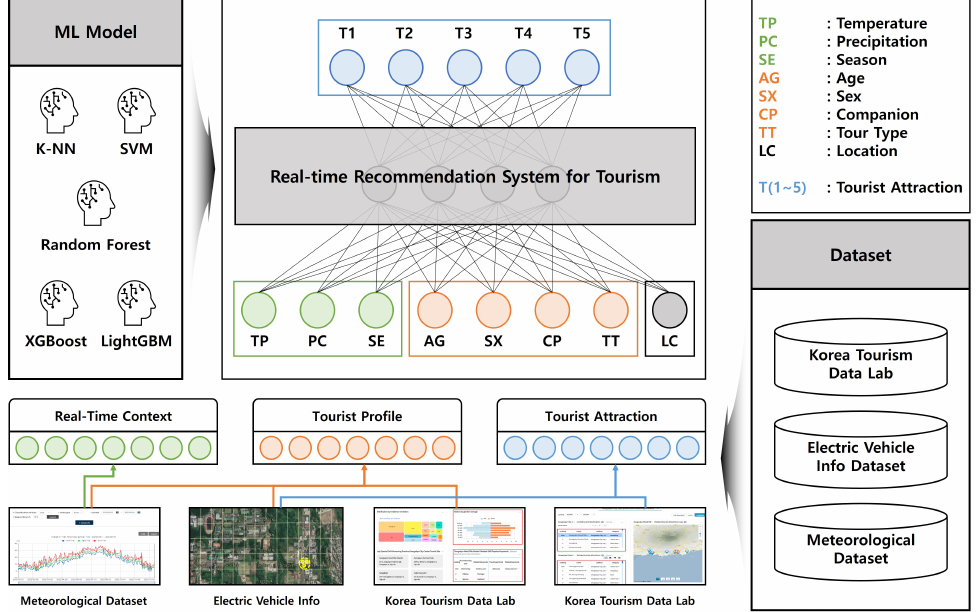
Figure 1. Architecture of real-time recommendation system for